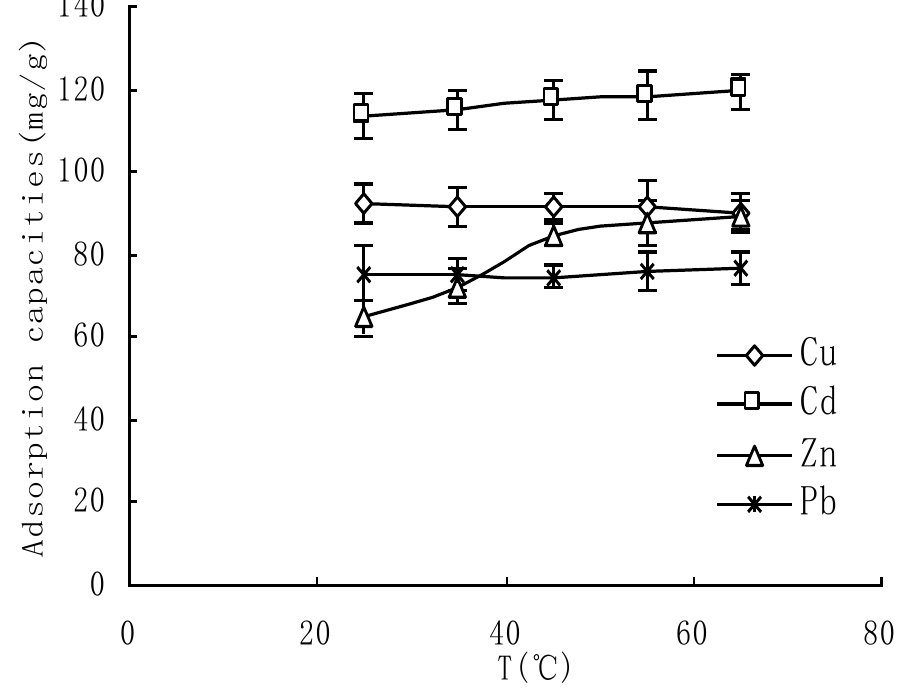
Figure 6. Influence of solution temperature on the adsorption capacities of CCM for the four heavy metal ions (initial metal concentration = 100 ppm; agitation speed = 180 rpm;